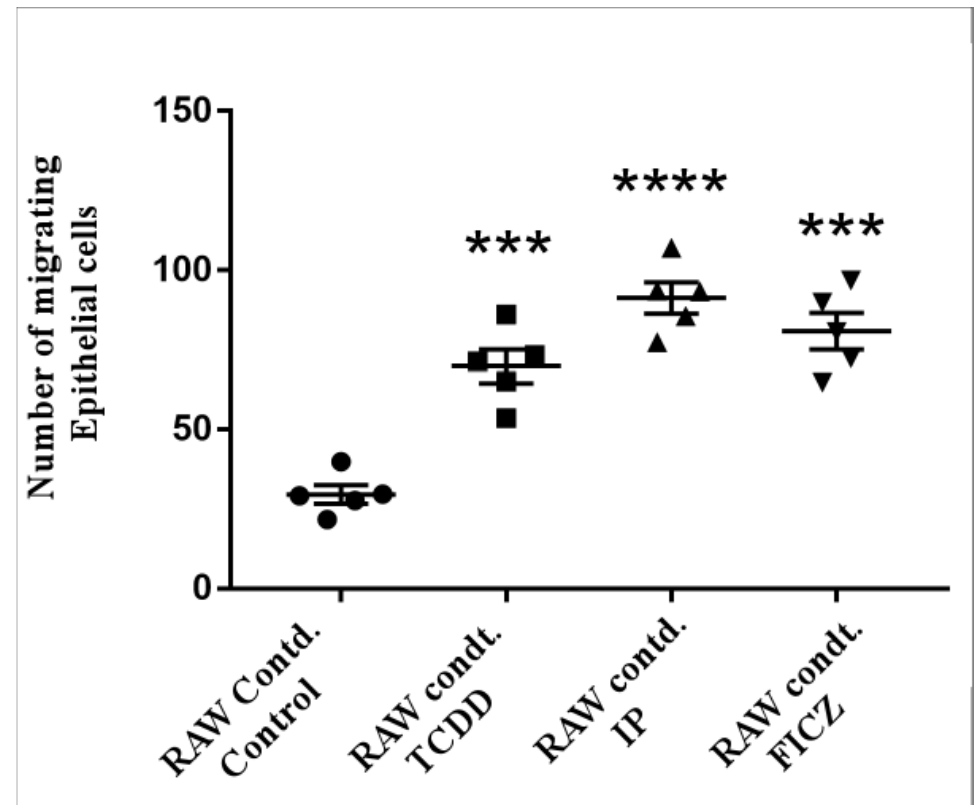
Figure 4. Migration of epithelial cells. In serum-free DMEM/F12 medium that contained TCDD (10 −8 M), IP (10 −7 M), FICZ (10 −7 M ) , MLE-12 cells were cultured for 24 h. Images were taken after 24 h. Crystal violet-stained cells took on a purple hue. The quantification of cells was performed as described above. The number of migrating cells was totaled and presented as folds of increase compared to control cells. Five independent experimental means ± SEM are represented in the graph. Unstimulated comparisons to control cultures were depicted by asterisks, such as *** p < 0.001 and **** p <0.0001 by one-way ANOVA analysis.